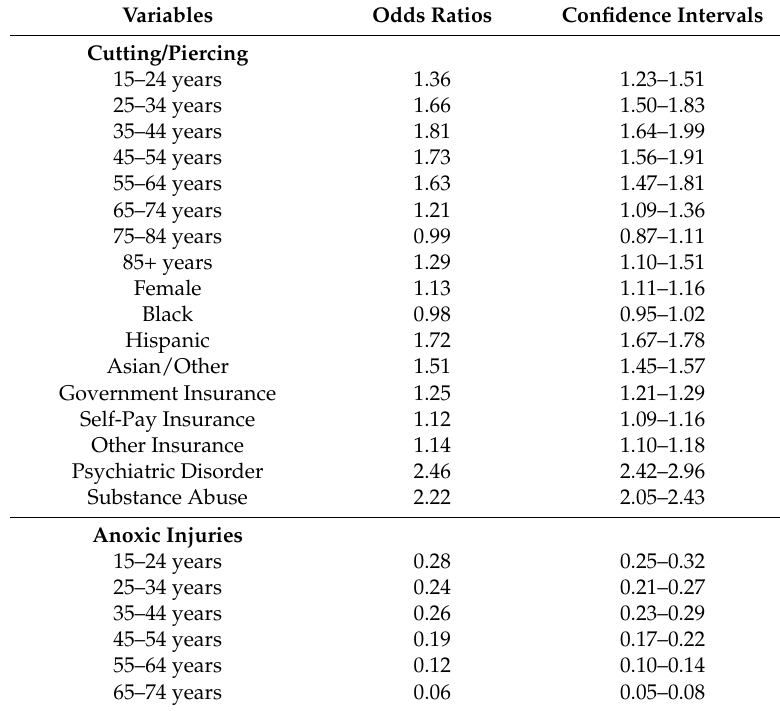
Table 3. Results of multinomial logistic regression